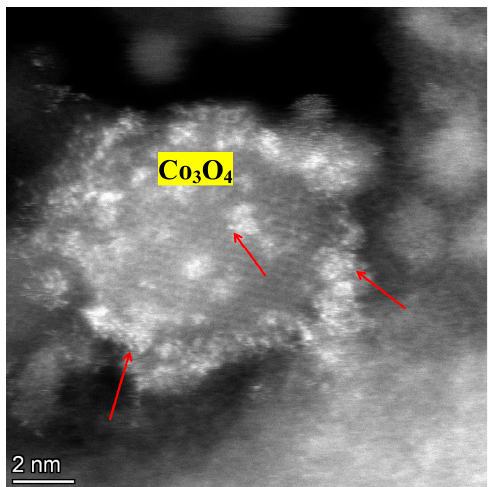
Figure 11. HAADF-STEM image of CoO x particle on the surface of Co-N-C/SiO 2 subjected to partial reduction with electron-beam irradiation. Red arrows show cobalt atoms formed.